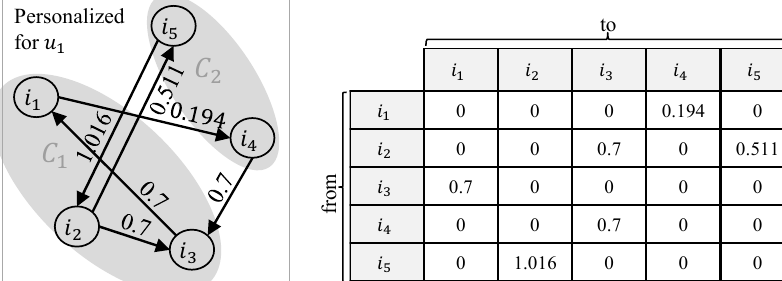
Figure 6. Construction of personalized graph and adjacency matrix. ( a ) A personalized graph in A 1 for u 1 . ( b ) An adjacency matrix for Figure